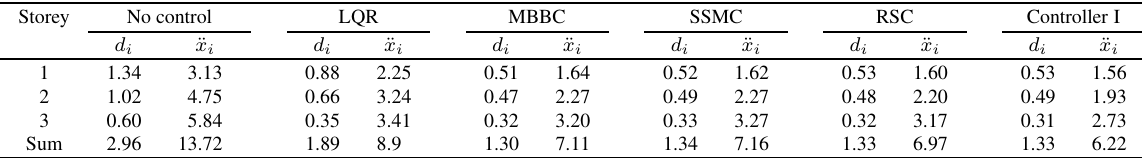
Table 1 Maximum response values for deterministic